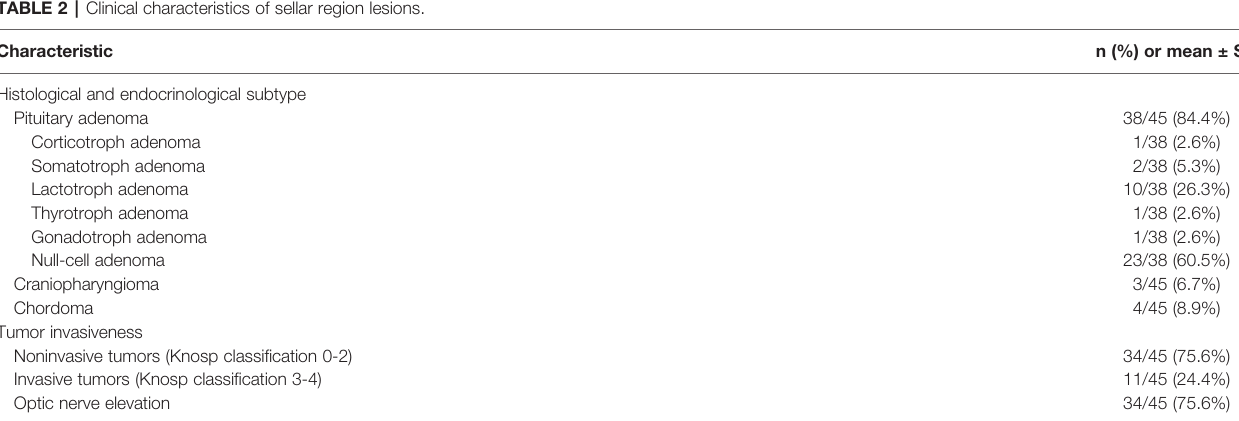
TABLE 2 | Clinical characteristics of sellar region lesions.